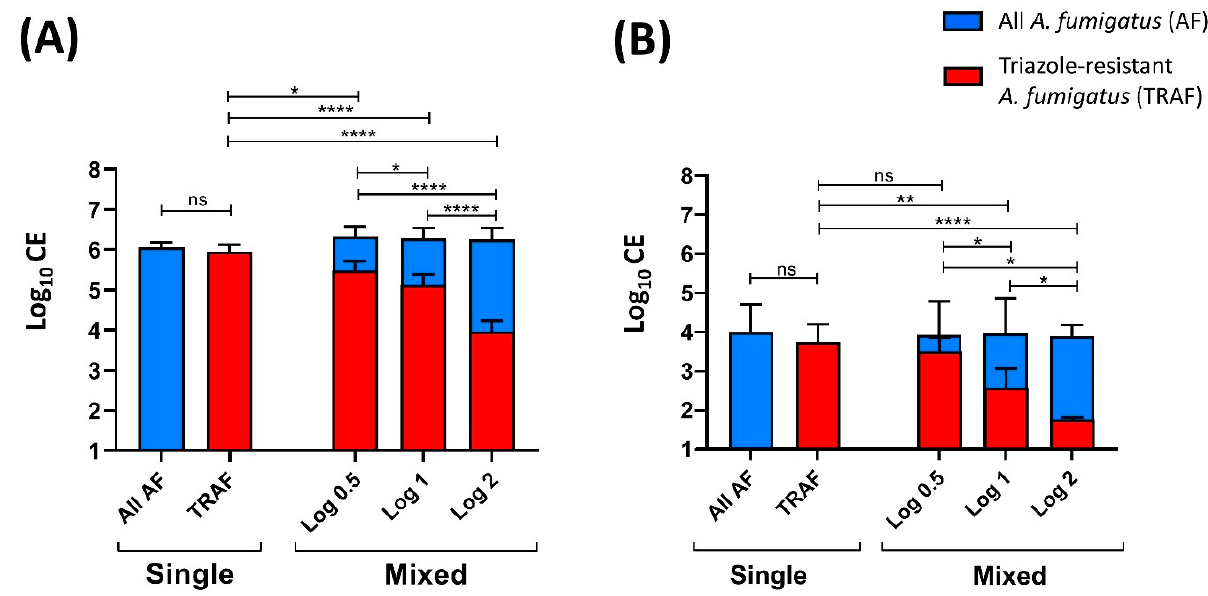
Figure 3. Quantitative ratio determination of triazole-resistant A. fumigatus in mixed susceptible and resistant Aspergillus samples. ( A ) In vitro quantification (conidial equivalents (CE)) of all A. fumigatus (AF) and of triazole-resistant AF (TRAF; TR 34 /L98H) ratios in single and mixed triazole- susceptible and triazole-resistant log ratios samples (0.5, 1, and 2 log 10 difference; final 1 × 10 6 spores). ( B ) In vivo CE log ratio quantification of infected Galleria mellonella larvae homogenates with single and mixed log ratios inoculum of triazole-susceptible and resistant conidia (0.5, 1, and 2 log 10 difference; final inoculum of 1 × 10 5 spores). Data are mean ± standard deviation (SD) of the results from multiple samples ( n = 9 ( A ), n = 6 ( B )). * p ≤ 0.05, ** p ≤ 0.005, *** p ≤ 0.0005 to single TRAF control (one-way repeated measures ANOVA) and between ratios (multiple comparison analysis; Sidak’s correction). ns: not